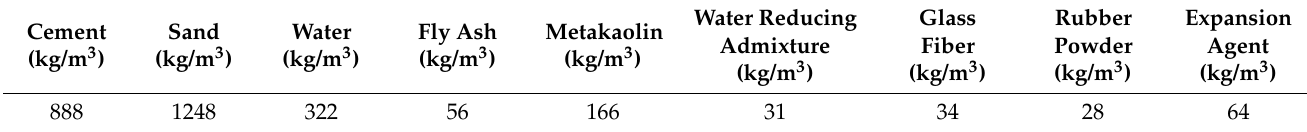
Table 1. Mix proportion of mortar of